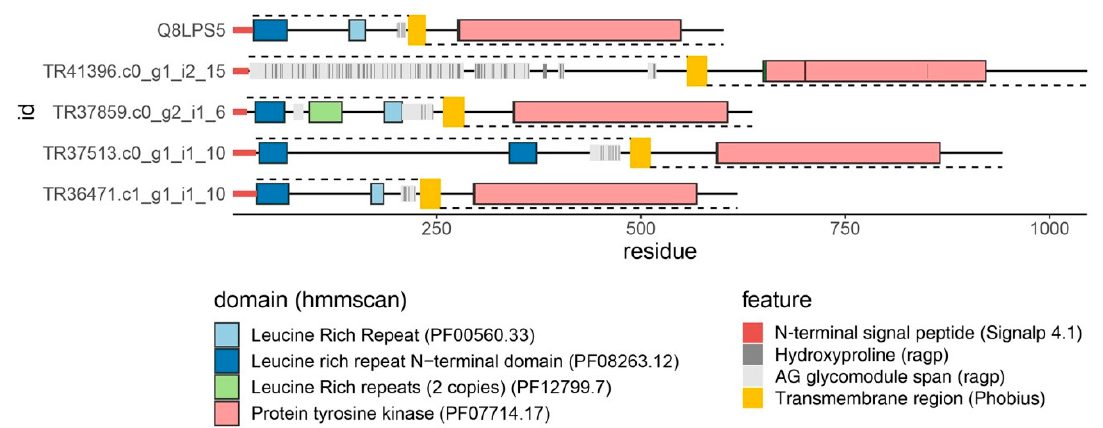
Figure 5. Arabinogalactan proteins (AGPs) with Tyr kinase domains. The first sequence is Somatic Embryogenesis Receptor-like Kinase 5 (SERK5) from A. thaliana (AT2G13800.1 or Q8LPS5 protein precursor). Four sequences below are found in the C. erythraea transcriptome, based on homology with SERK5. In addition to AG glycomodules with predicted hydroxyprolines and Tyr kinase domains, all sequences have N-terminal signal peptide and a transmembrane domain, while most have Leucine-rich repeats typical for SERK receptors. The image is generated using ragp.